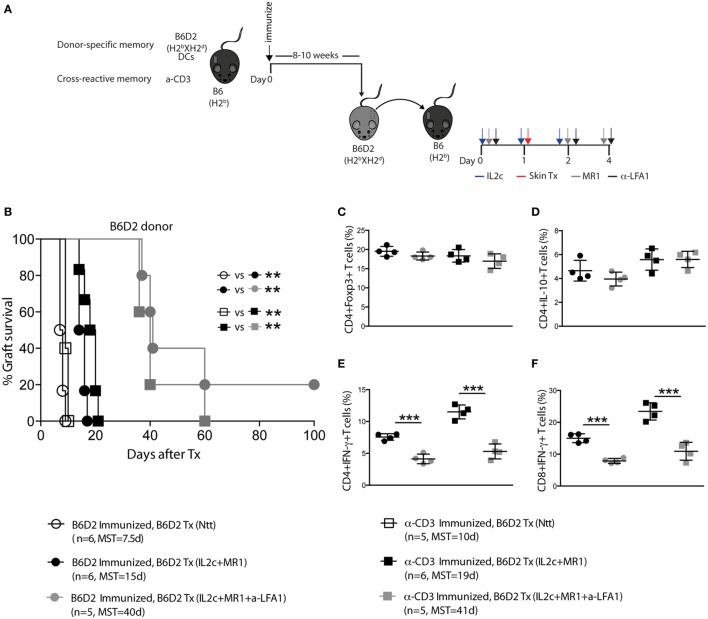
IL2c in combination with MR1 prolongs MHC-mismatched skin graft survival in the presence of preexisting memory T cells, and this effect is enhanced by anti-LFA-1 treatment. (A) Recipient B6 mice were immunized with either 5 × 105 B6D2 mature dendritic cells (DC) (circles) or 0.5 mg/kg anti-CD3 (squares), followed 8–10 weeks later by a B6D2 skin graft. Mice were left untreated (Ntt) or received IL2c + MR1, with or without anti-LFA-1 (black and gray symbols, respectively). (B) Graft survival. (C–F) Phenotype and effector function of T cells in the draining lymph nodes at rejection. Frequency of (C) CD4+Foxp3+; (D) CD4+IL-10+; (E) CD4+IFN-γ+, and (F) CD8+IFN-γ+ T cells. n = 4–6 mice/group (*P < 0.05, **P < 0.01, and ***P < 0.001).